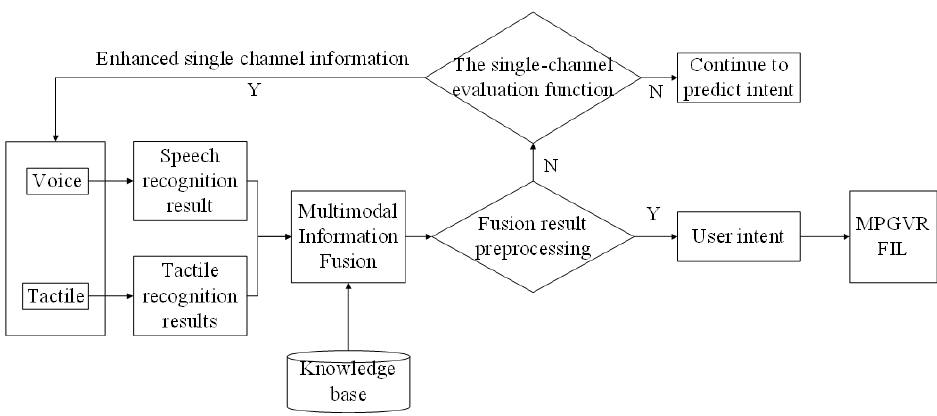
Figure 4. Multimodal intention active understanding algorithm framework.